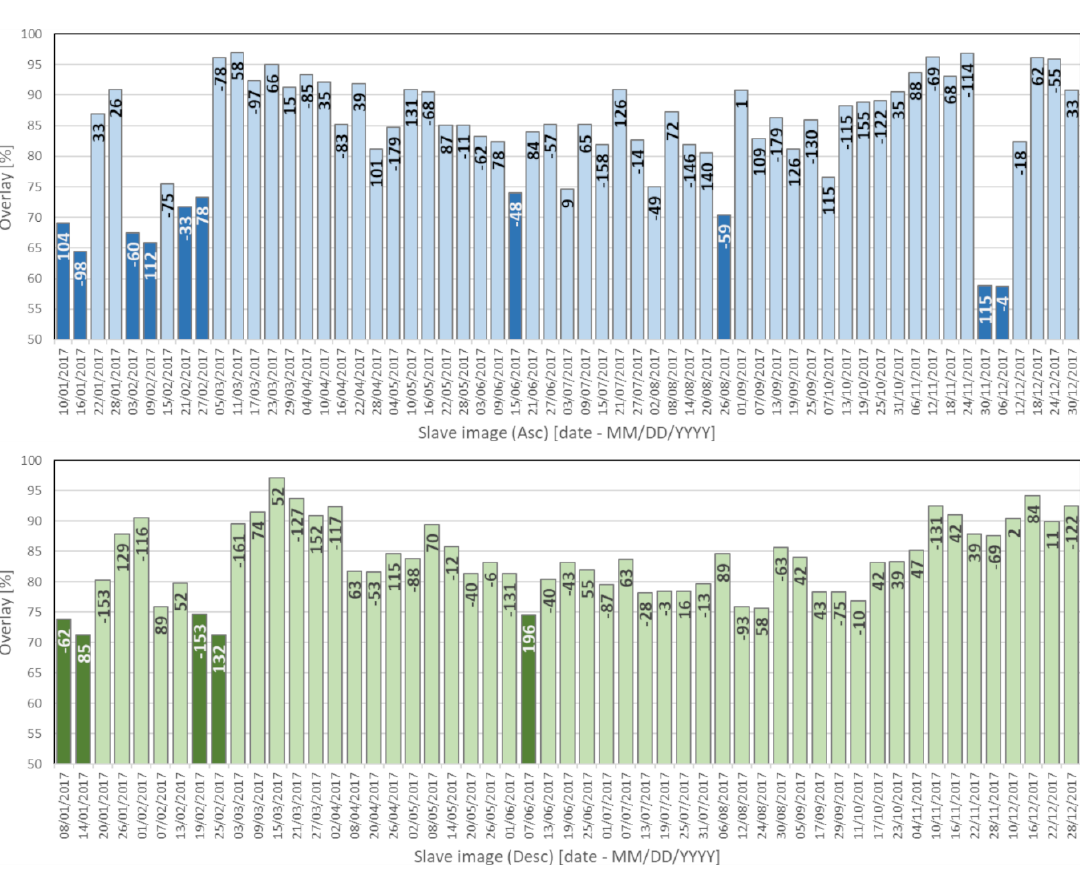
Figure 4. Quality assessment of the ascending (Asc) and descending (Desc) interferograms. The values in the bars show the perpendicular baselines of each interferogram.